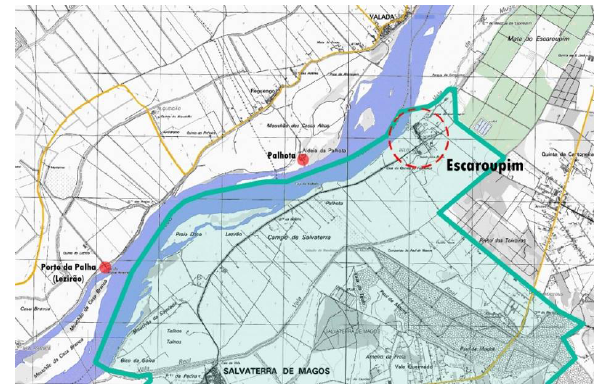
Figure 2: Escaroupim: accessibilities (road infrastructures). Graphic scale. Adapted from Carta Militar de Portugal, 1:25 000, 2007, Folha